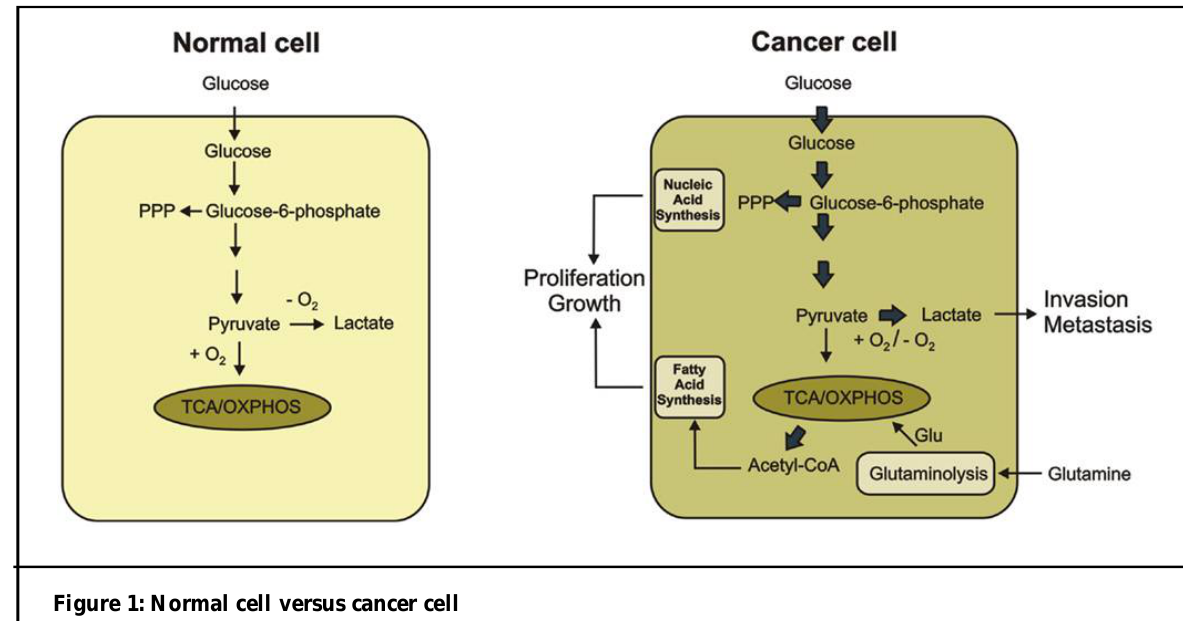
Figure 1: Normal cell versus cancer